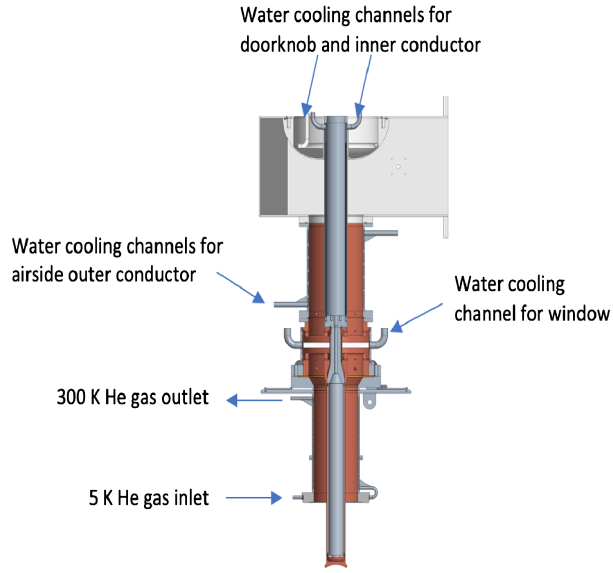
FIG. 16. Conceptual design of 591 MHz FPC for ESR SRF